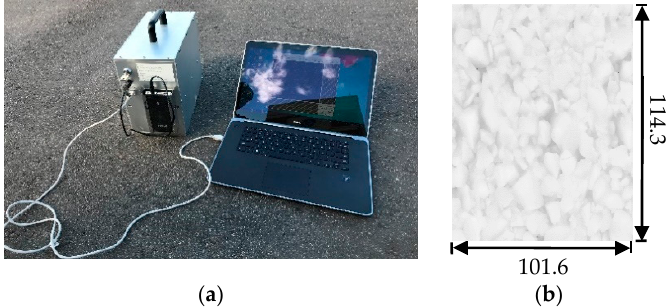
Figure 3. LS-40 pavement surface texture scanner and example of the data: ( a ) LS-40 PorTable 3D Surface Analyzer (HyMIT Measurement Instrument Technology, Austin, TX, USA); ( b ) Example 3D Range Image (unit: mm)/.